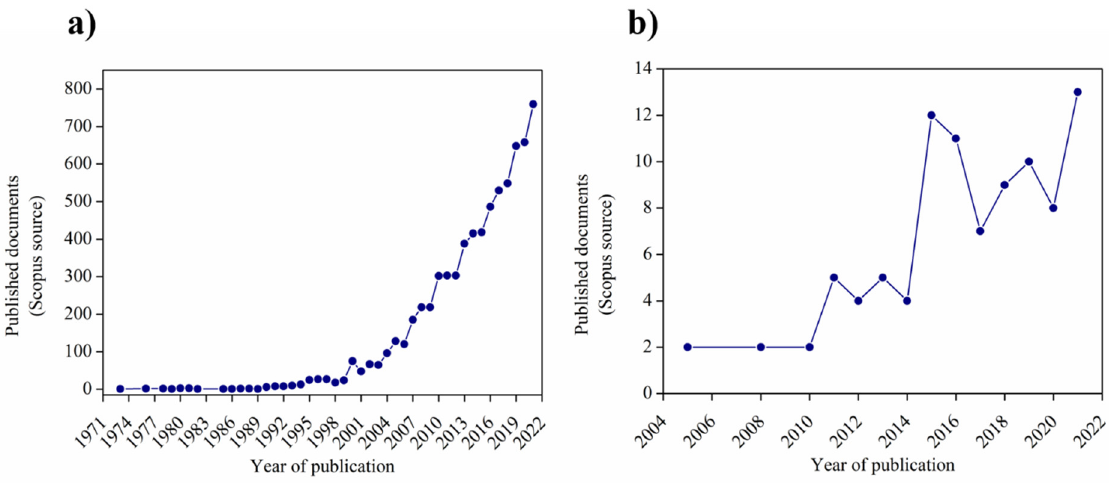
Figure 7. Number of published scientific papers looking for keywords: ( a ) “shape memory” + “polymers”; ( b ) “shape memory” + “polymers” + “electrospinning”.